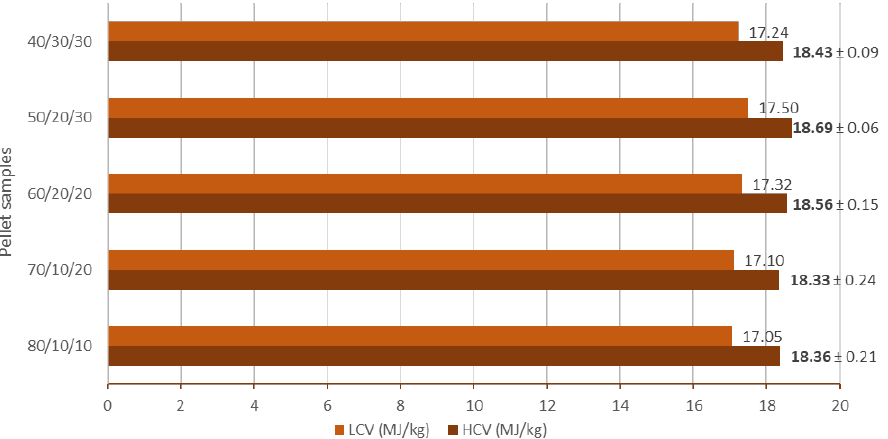
Figure 5. Results from calorific value analysis of produced pellets.